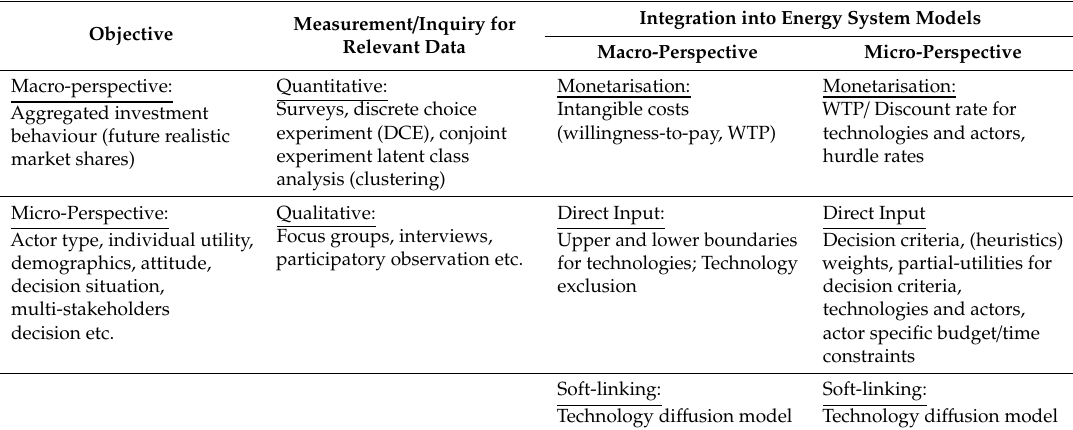
Table 1. Overview of objectives, methods of empirical data inquiry and possibilities to integrate aspects of investment behaviour into energy system models